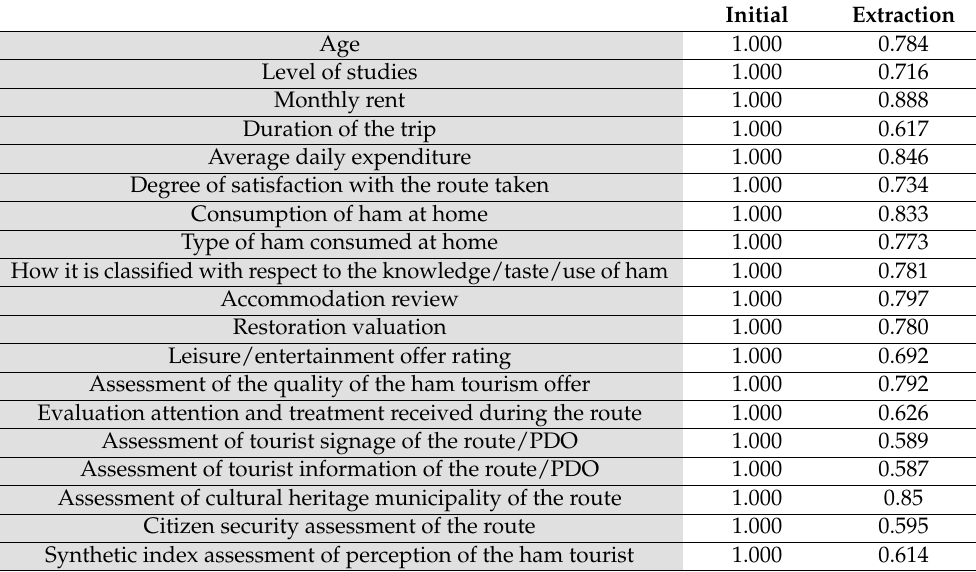
Table 5. Communalities. Extraction method: principal component